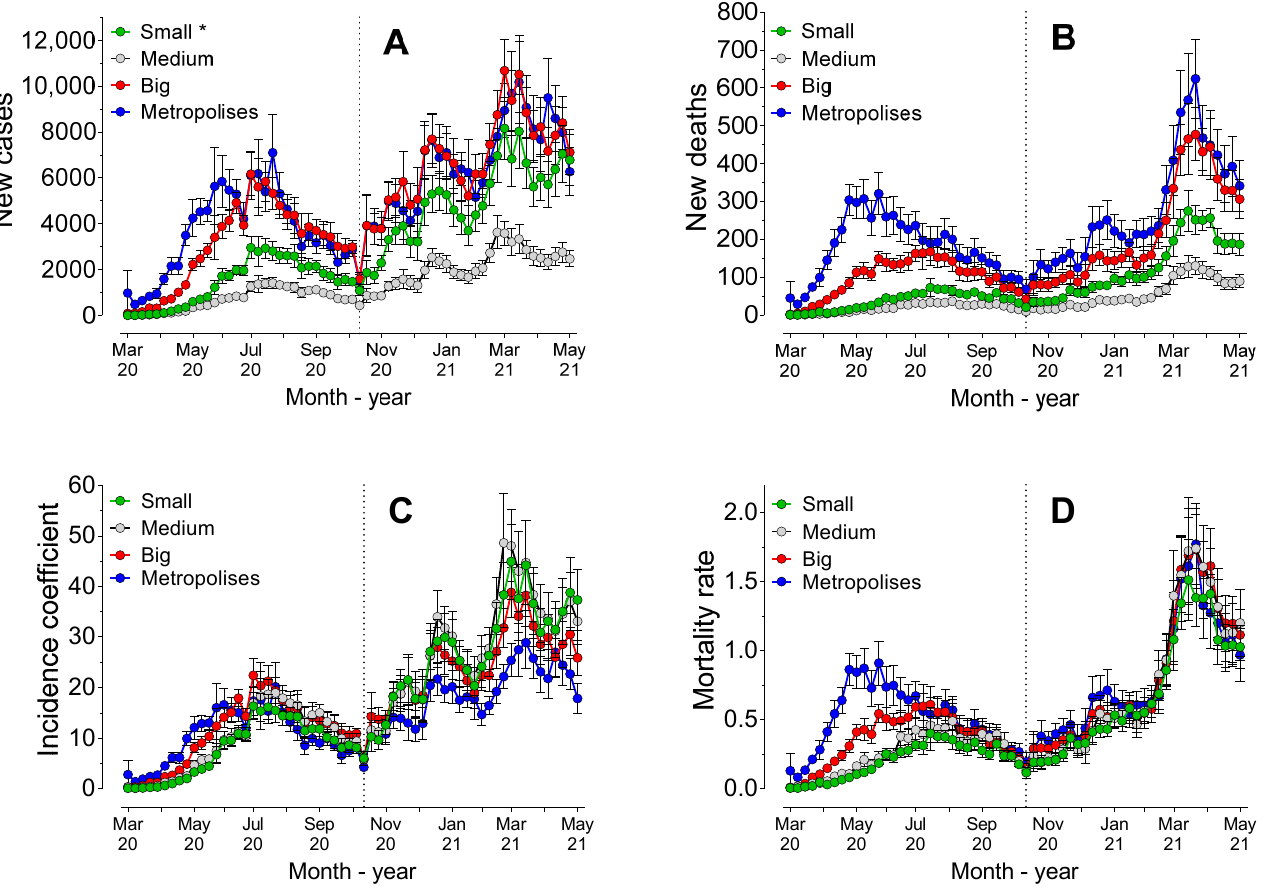
Figure 3. Mean (±standard error) of cases ( A ) and new deaths ( B ), incidence coefficients ( C ), and mortality rates ( D ) during the 62 weeks of the pandemic, considering the four strata of population sizes of the municipalities. * Small cities (under 50,000 inhabitants); medium cities (50,000 to 100,000 inhabitants); big cities (100,000 to 500,000 inhabitants); and metropolises (over 500,000 inhabitants). Analysis of the areas under the curve (AUC) values of the number of cases revealed that there were no statistically significant differences ( p = 0.31) between the cities classified as “metropolis” and “big”, which showed a higher AUC value than those of the other population sizes. The lowest AUC value ( p < 0.0001) was observed for the municipalities with medium size populations. However, the AUC values of the number of deaths